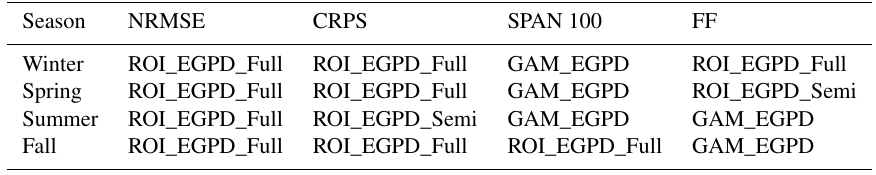
Table 2. Summary of the comparison results from the four criteria used. For each season and criterion, the model with the highest median is shown. In the case of the CRPS score, however, the model with the smallest median CRPS is shown.